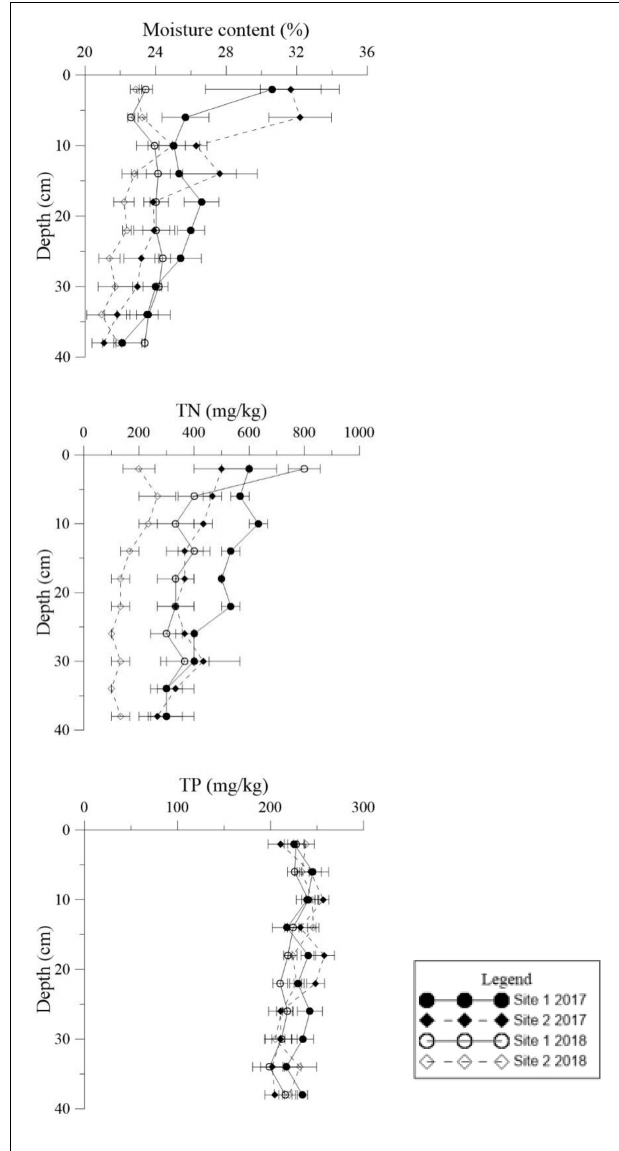
FIGURE 4 | Vertical distributions of moisture content, total phosphorus (TP), and total nitrogen (TN) in the deep sediment cores from the two study sites in May 2017 and May 2018.